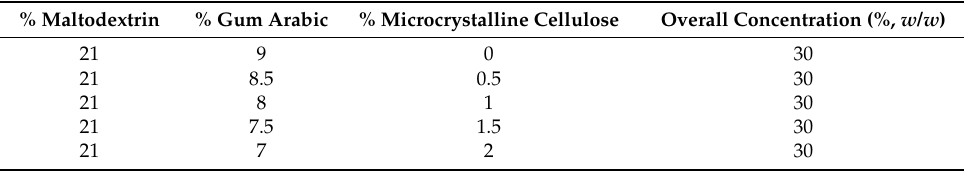
Table 1. Concentrations of carrier agents used the